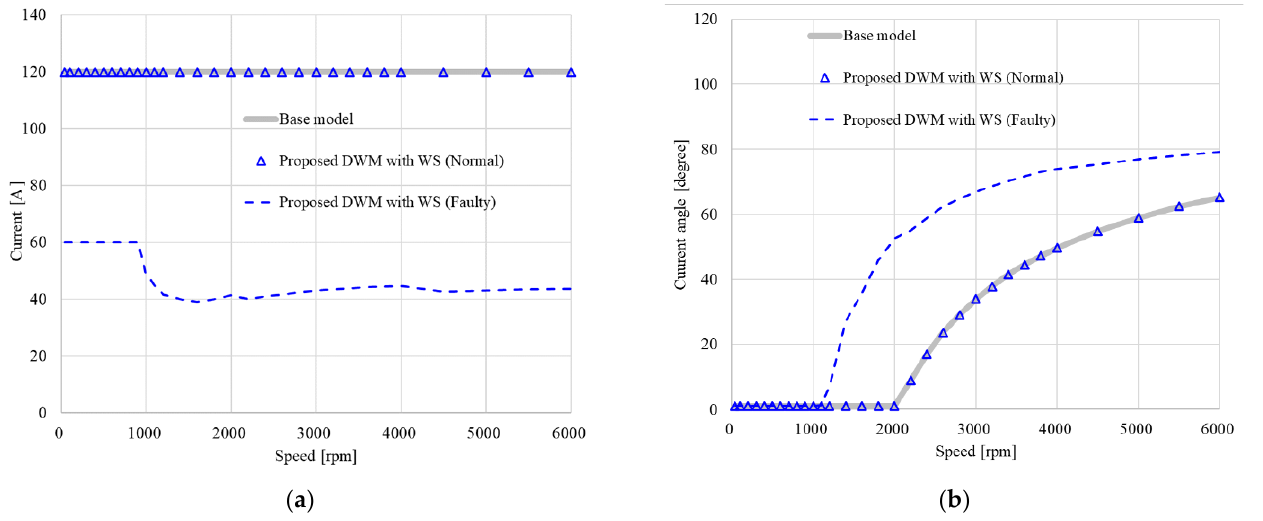
Figure 15. Comparison of the peak current and current angle characteristics between the base model and the proposed DWM with WS: ( a ) Current; ( b ) Current angle.